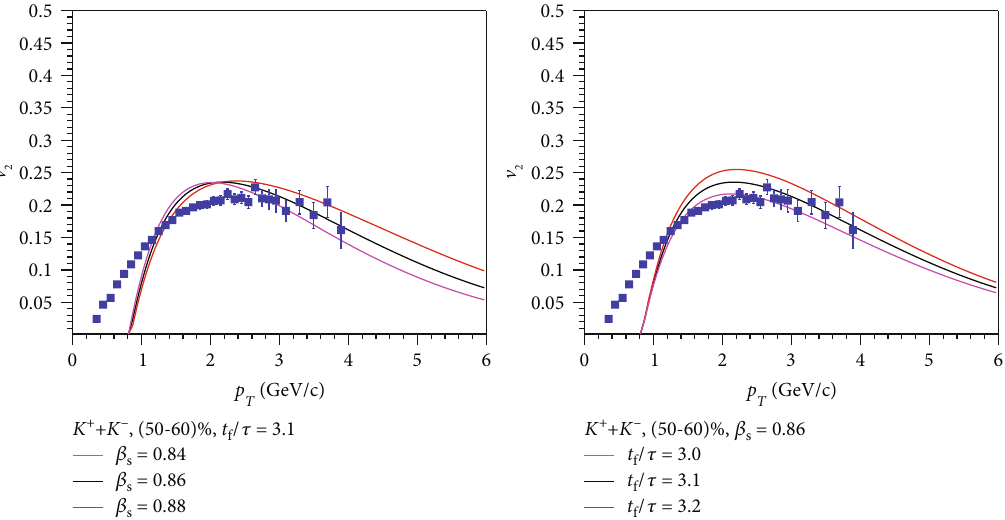
ffiffiffiffiffiffiffiffi p = 2 : 76TeV . Symbols s NN